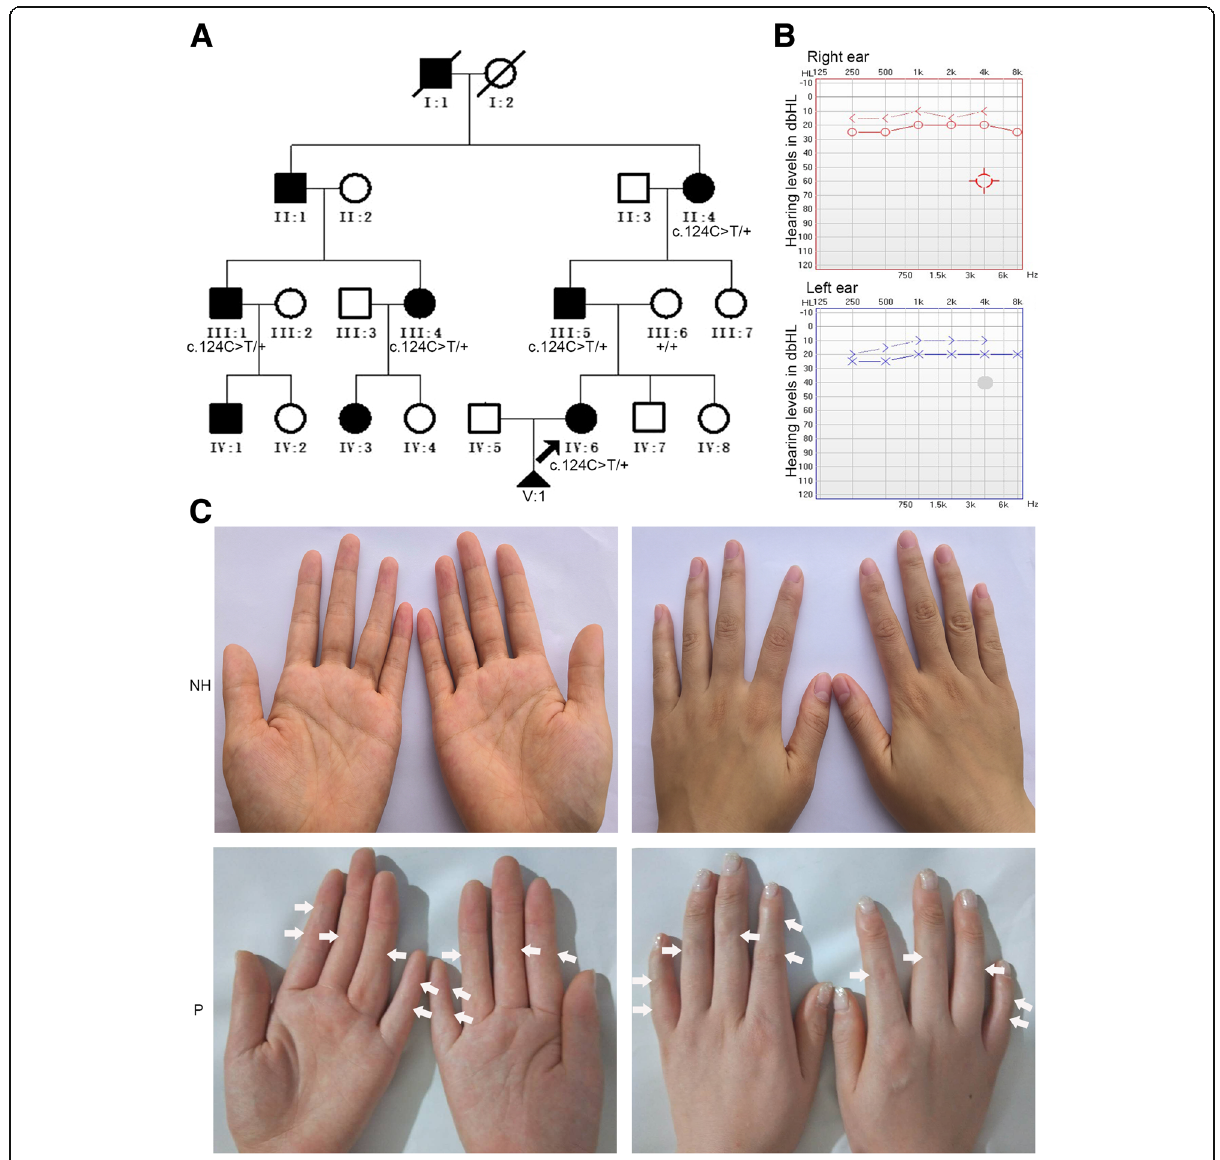
Fig. 1 A four-generation Chinese family with autosomal dominant SYM1. a Black squares or circles represent individuals suffering from SYM1. The black arrow indicates the proband (IV: 6). Individuals I:1 has the abnormal phenotype, according to the descriptions of their relatives. b Audiogram from the proband showing normal hearing level. c Photographs showing the proband ’ s hand (The places where the curved creases disappear are marked with white arrows) and the hand of a normal